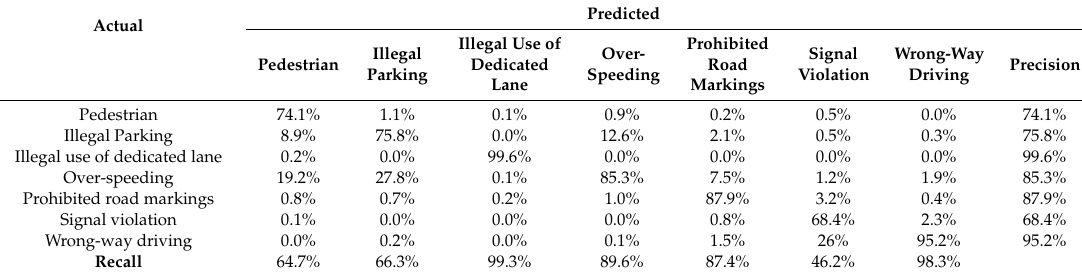
Table 5. Confusion matrix for stack